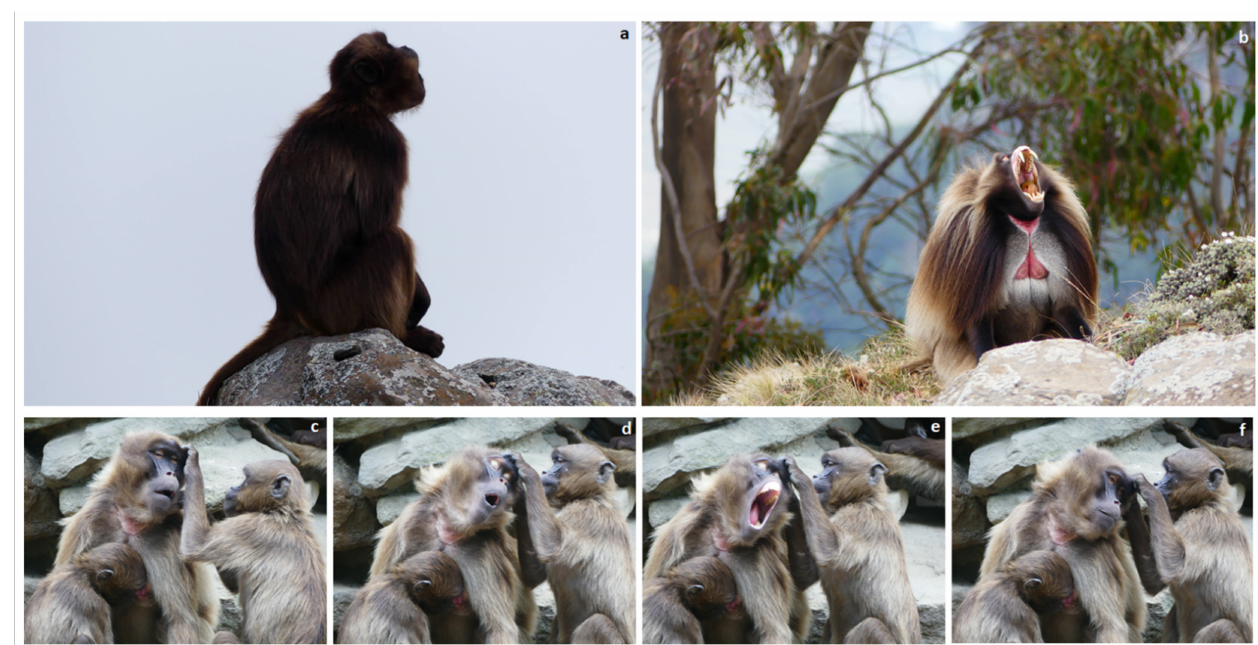
Figure 4. The same yawn variability is present both in captive and wild conditions. Two examples of yawning in geladas (a-b: Amhara region, Ethiopia; c-f: NaturZoo, Rheine). ( a ) yawn with covered teeth from a subadult male and ( b ) yawn with uncovered gums from an adult male. ( c – f ) Sequence of a yawning event performed by an adult female while receiving grooming from a juvenile female. Yawns with uncovered gums can be performed both by males and females. Photo: Elisabetta